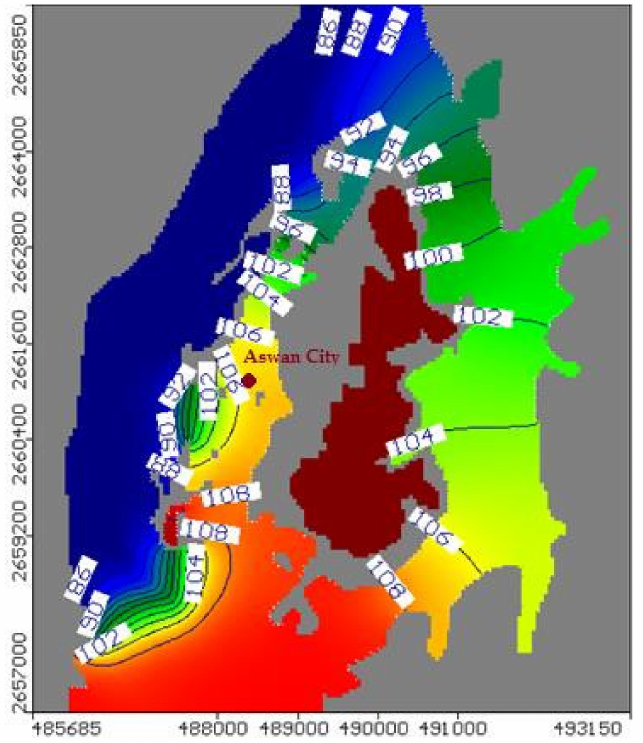
Figure 7. Distribution of groundwater heads in Aswan city.